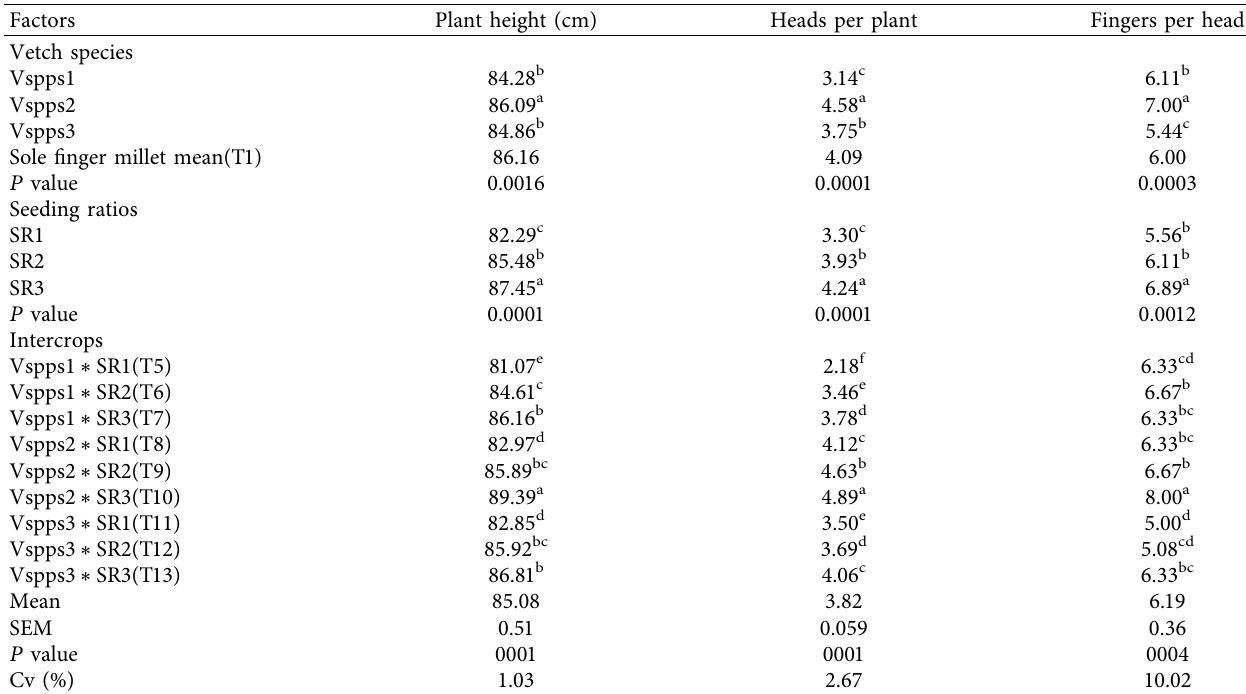
Table 2: Main effects and interaction effect of vetch species and seeding ratio on plant height, heads per plant, fingers per head, and leaf to stem ratio of finger